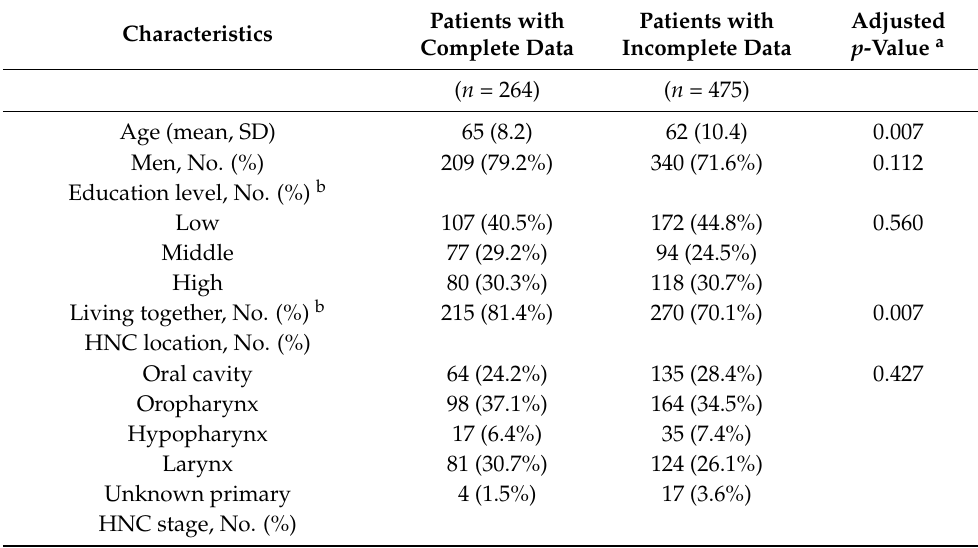
Table 1. Characteristics of patients with complete data (the study population) vs. patients with incomplete